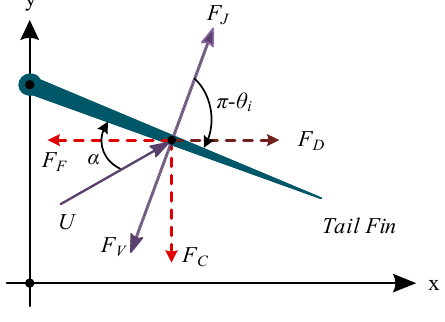
Figure 6. Hydrodynamic force distributions acting on the tail.